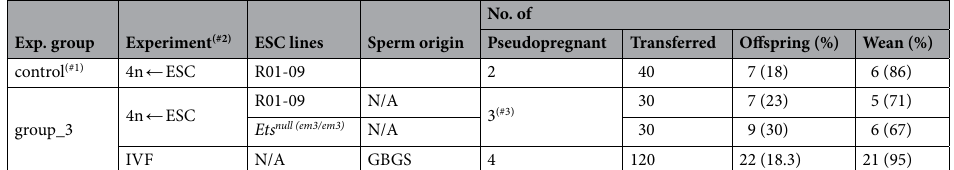
Table 4. Embryo transfer using the LHRHa treated pseudopregnant female. (#1) Pseudopregnant female mice of control were prepared by the visual method. (#2) 4n ← ESC refers to embryos manipulated by tetraploid complementation; IVF refers to embryos obtained by in vitro fertilization. (#3) In all three female mice, ten R01-09 embryos were transferred into the left uteri, and ten Ets2 null (em3/em3) embryos were transferred into the right uteri. R01-09 offspring were recognized by RFP fluorescence signal, and Ets2 null (em3/em3) offspring were recognized by wavy hairs, which is known as Ets2-null mutant phenotype, after 10-day old. N/A not applicable.